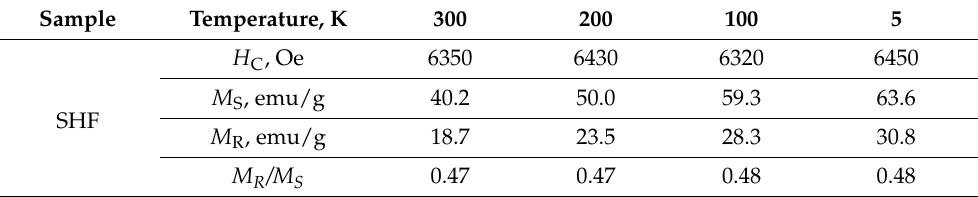
Table 3. Magnetic properties of the uncovered SrFe 10 Cr 2 O 19 (SHF) nanoparticles and composite sam- ples (FO_32 and FO_11) at different temperatures. H C represents coercivity, M S — sample magneti- zation at 30 kOe, M R — remanent magnetization.